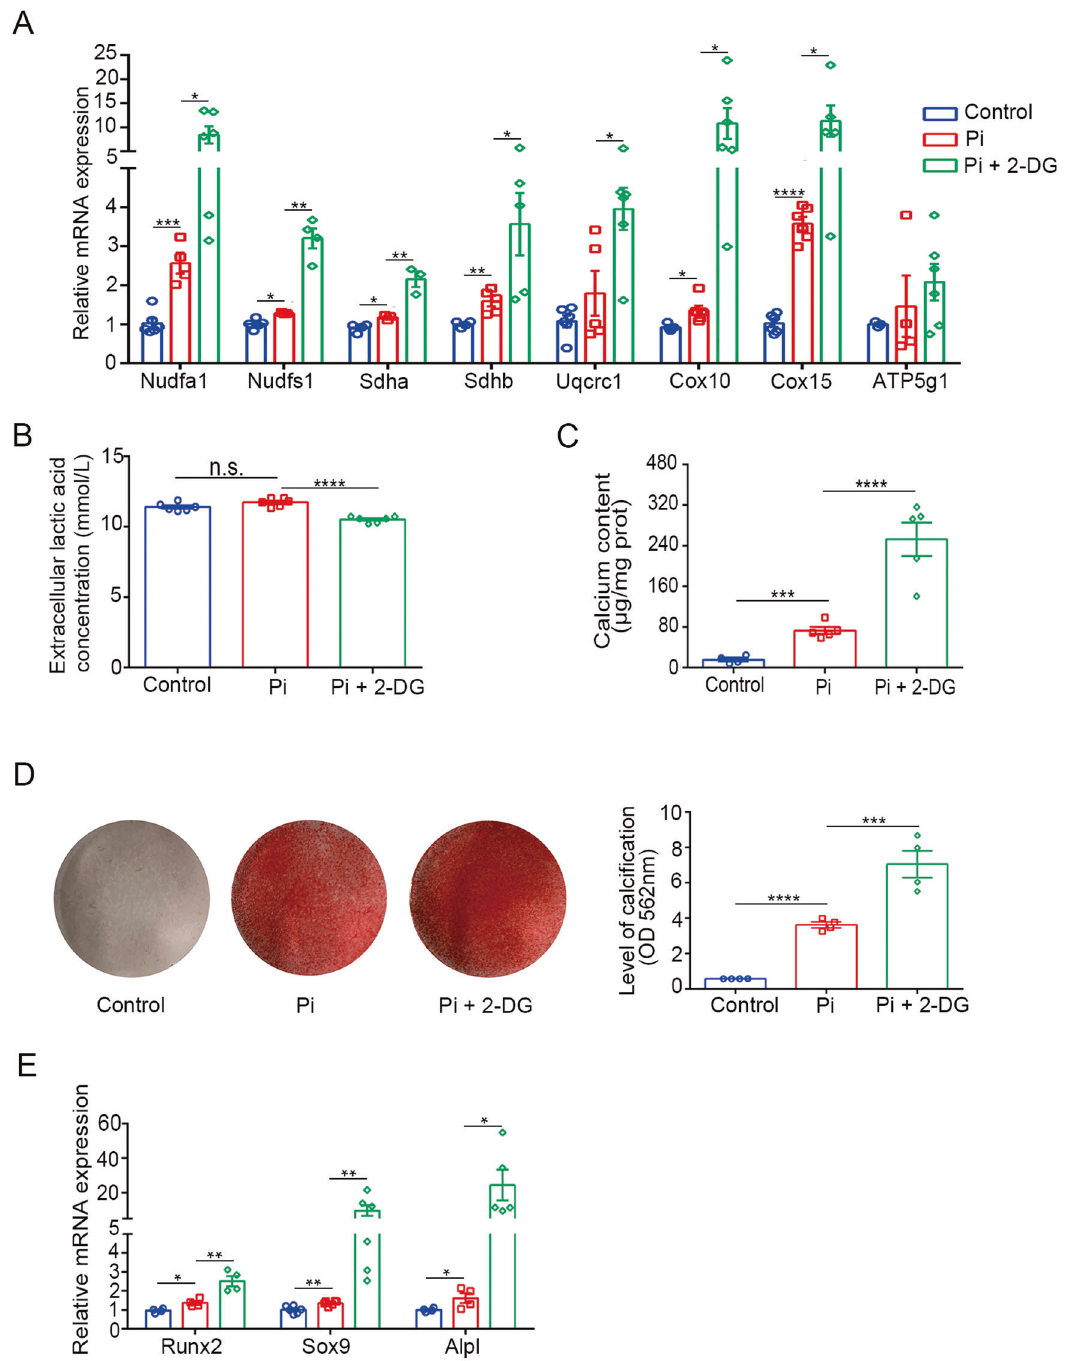
Fig. 4 2-DG accelerated high phosphate-induced calci fi cation by upregulating OXPHOS. A Relative mRNA expression of OXPHOS-related genes in HASMC as detected by RT-qPCR (one-way ANOVA; n = 4 – 6). B Extracellular lactic acid concentration of HASMC (one-way ANOVA; n = 6). C Total calcium content in HASMC (one-way ANOVA; n = 5). D Representative images and quanti fi cation of Alizarin red staining of HASMC (one-way ANOVA; n = 4). E Relative mRNA expression of Runx2, Sox9, ALPL in HASMC as detected by RT-qPCR (one-way ANOVA; n = 4 – 6). * P < 0.05, ** P < 0.01, *** P < 0.001, **** P < we further divided CKD patients into two groups. The relationship between COX15 staining levels and clinicopathological factors are summarized in Table 1. No signi fi cant difference in the characteristics, including blood urea nitrogen, creatinine, and parathyroid hormones, was observed between the two groups. Among 34 patients in our cohort, chest computed tomography was conducted in 29 patients (85.3%), which was used to measure